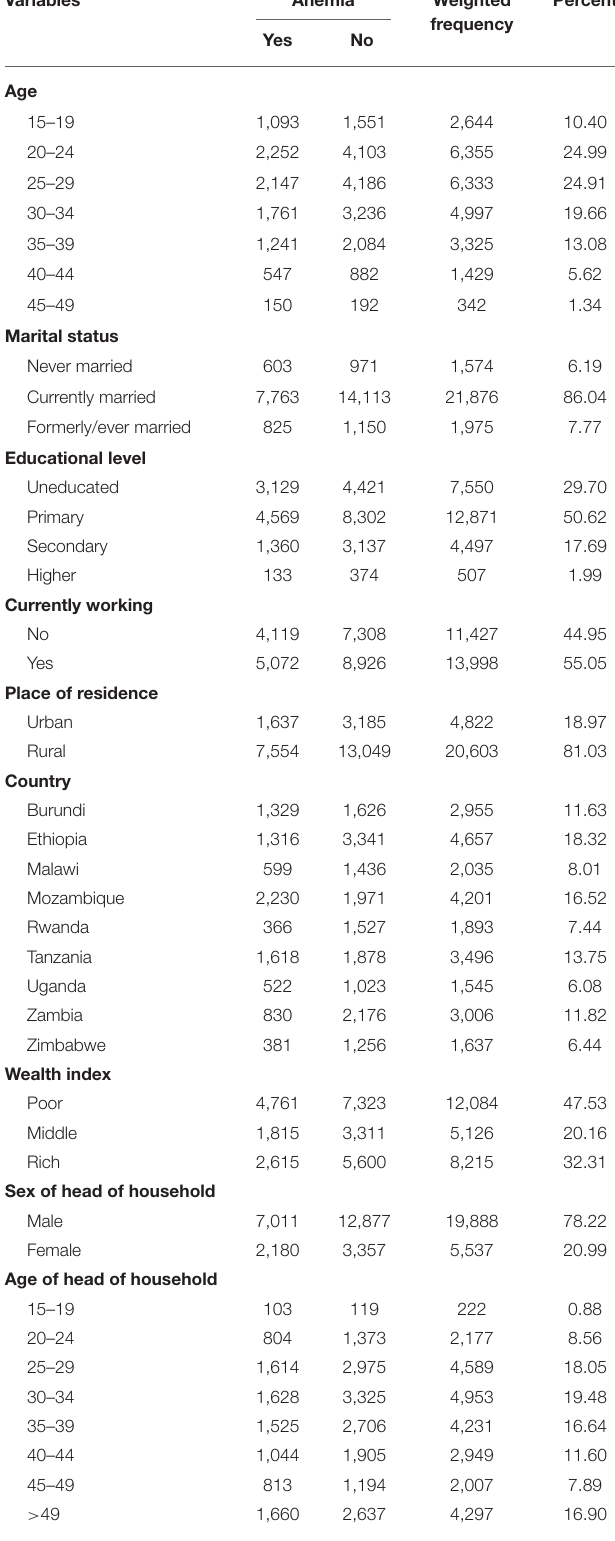
TABLE 1 | Model comparison between fixed effect and mixed effect logistic regression. Proposed model